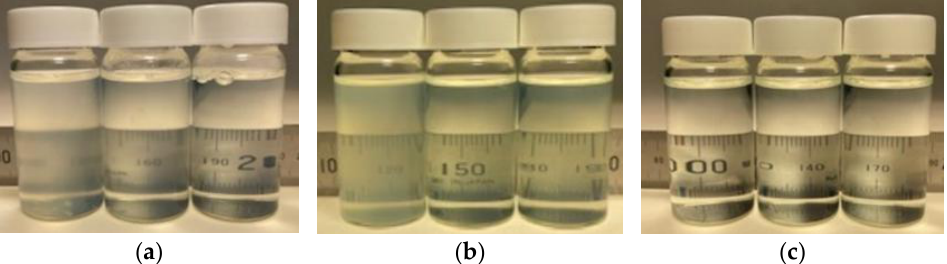
Figure 7. Photograph of BL-01, BL-03 and BL-05 alkaline solution: ( a ) from left to right, 10% BL-01